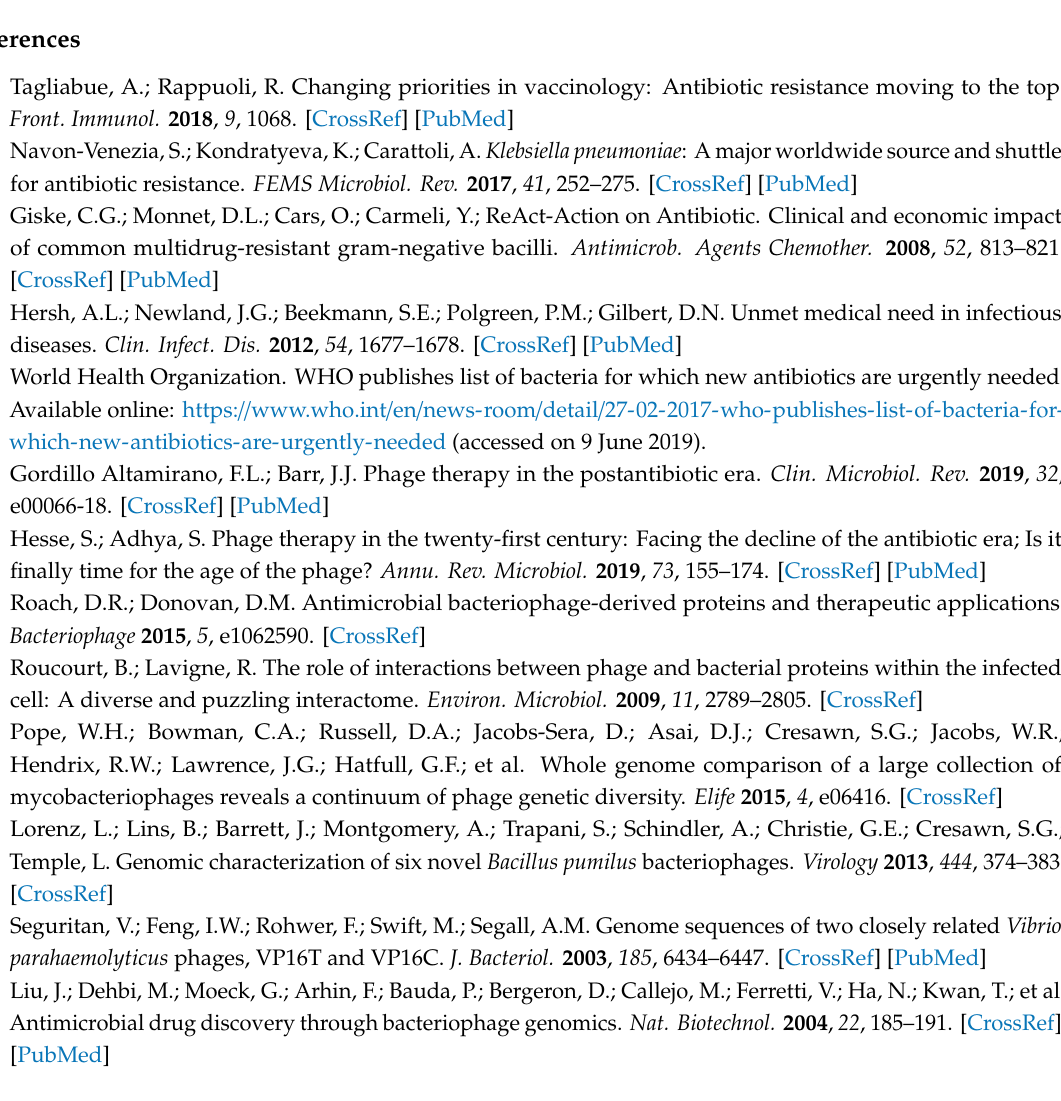
Table S4 : Genome typing analysis of representative K. pneumoniae strains carried out with the Kleborate tool, Table S5 : CFU counts relative to the CFU of Gp178 in that batch of